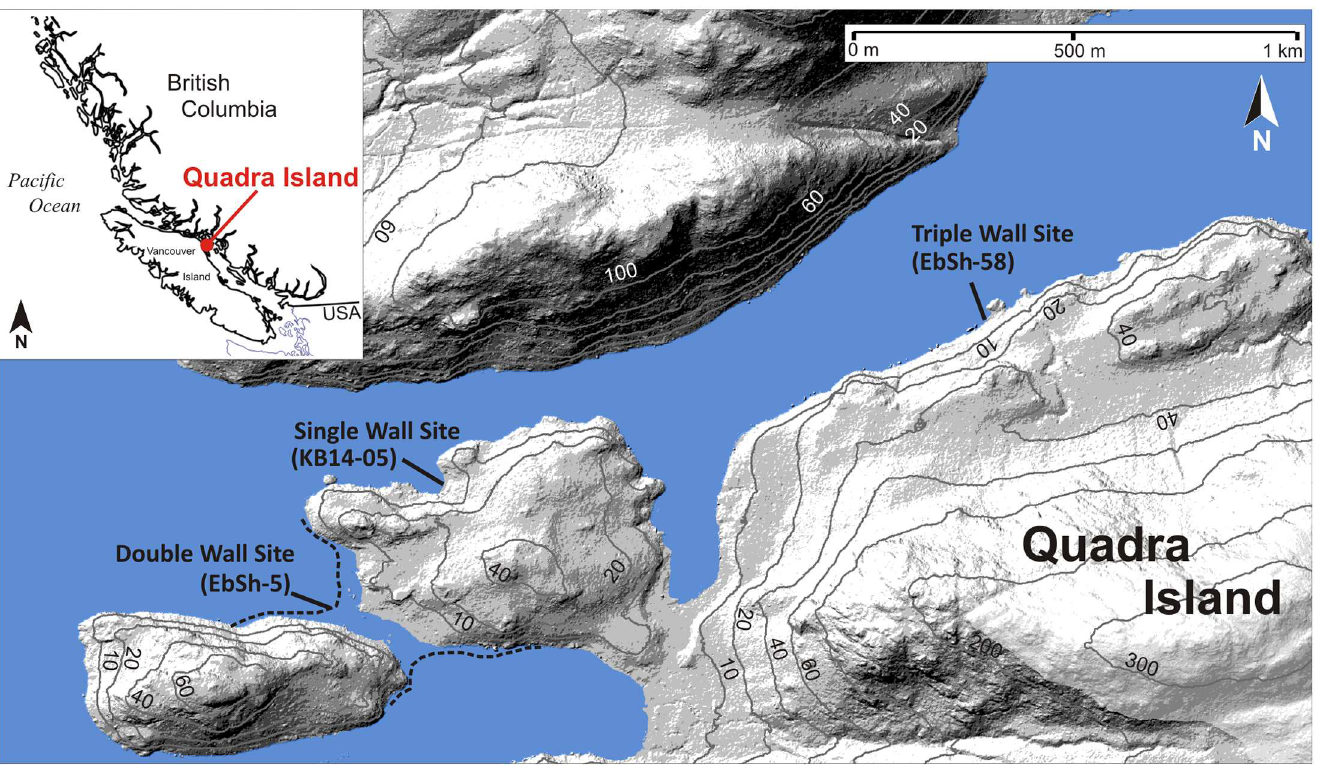
Fig 1. Locations of clam garden study sites superimposed on a hillshaded and contoured LiDAR digital elevation model (averagepoint density of 18.2 pts/m 2 ). The LiDAR data were obtained and processedby Rob Vogt of the University of NorthernBritish ColumbiaLidar ResearchGroup and Derek Heathfieldof the Hakai Institute Coastal Sand Ecosystems